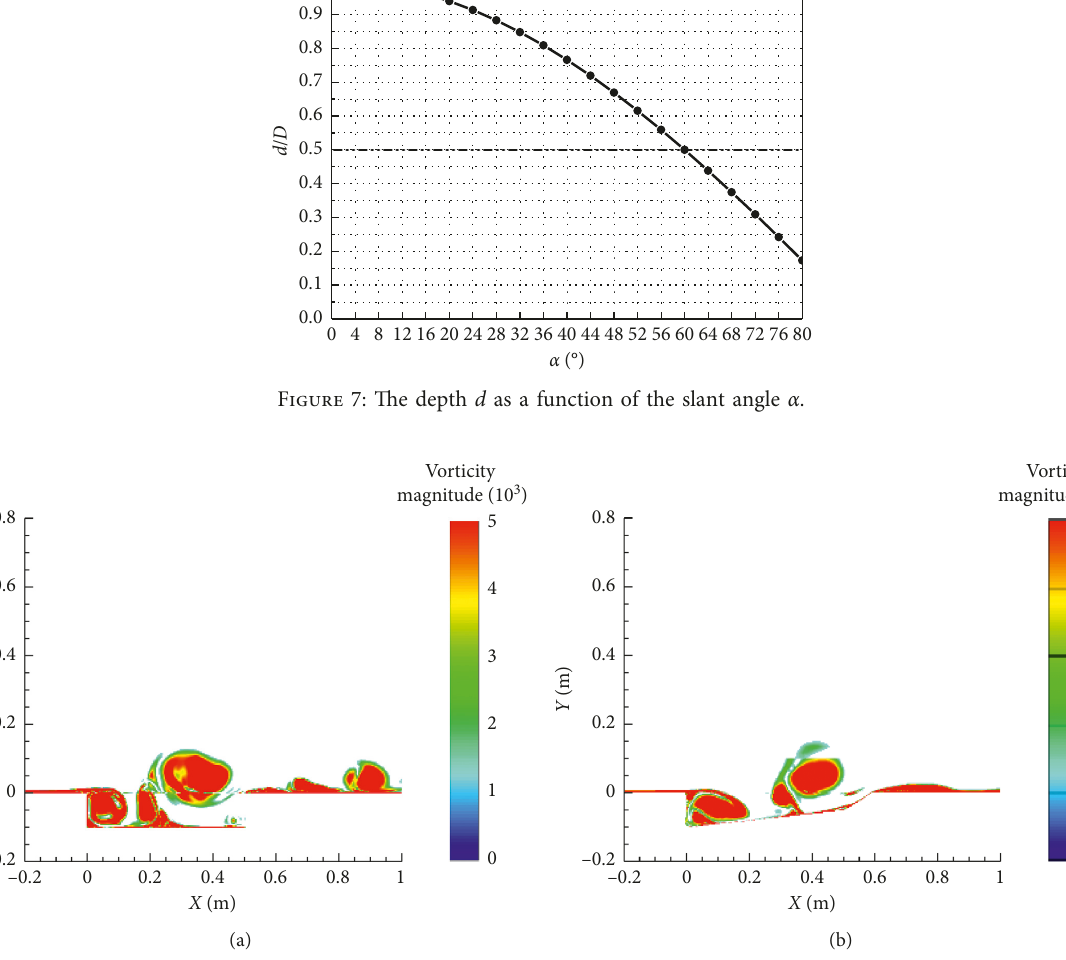
Figure 8: Comparison of the instantaneous vorticity contours of the rectangle cavity ( α � 0 ° ) at t � 4/6 T (a) and deformable cavity ( α � 60 ° ) at t ′ � 4/6 T ′ (b).